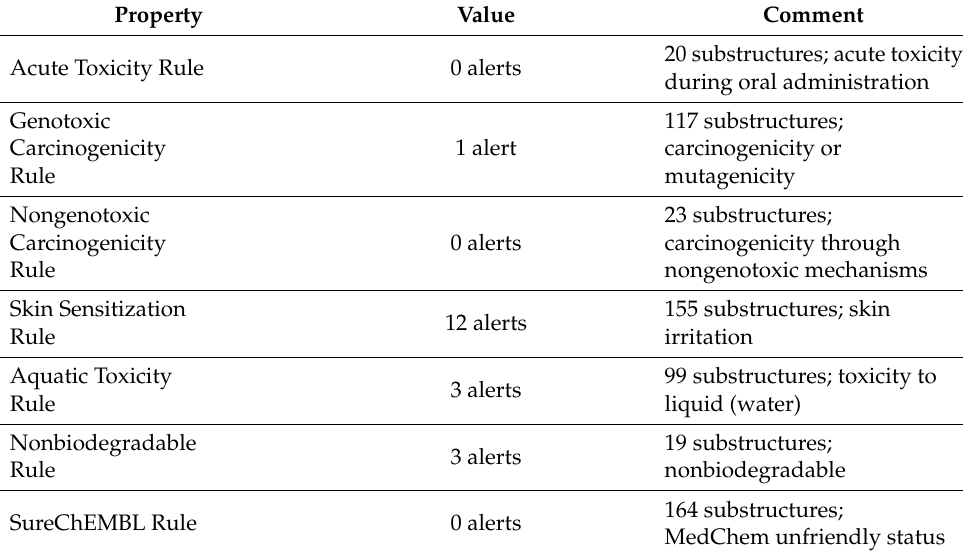
Table 14. Toxicophore rules of compound 1